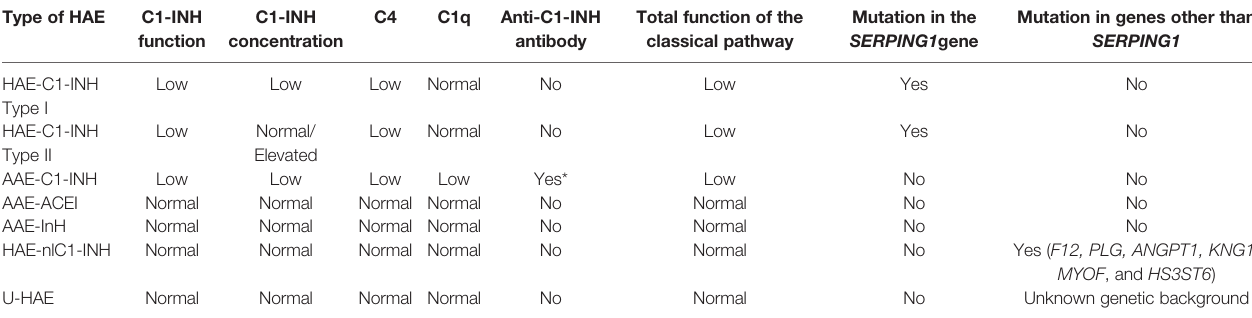
*Anti-C1-INH antibody is not present in all the patients. HAE-C1-INH: Hereditary Angioedema with C1 inhibitor de fi ciency; AAE-C1-INH: Acquired Angioedema with C1 inhibitor de fi ciency; AAE-ACEi: Acquired angioedema induced by angiotensin-converting enzyme inhibitors; HAE-nlC1-INH: Hereditary Angioedema with normal C1 inhibitor; U-HAE: Hereditary Angioedema with normal C1 inhibitor and unknown